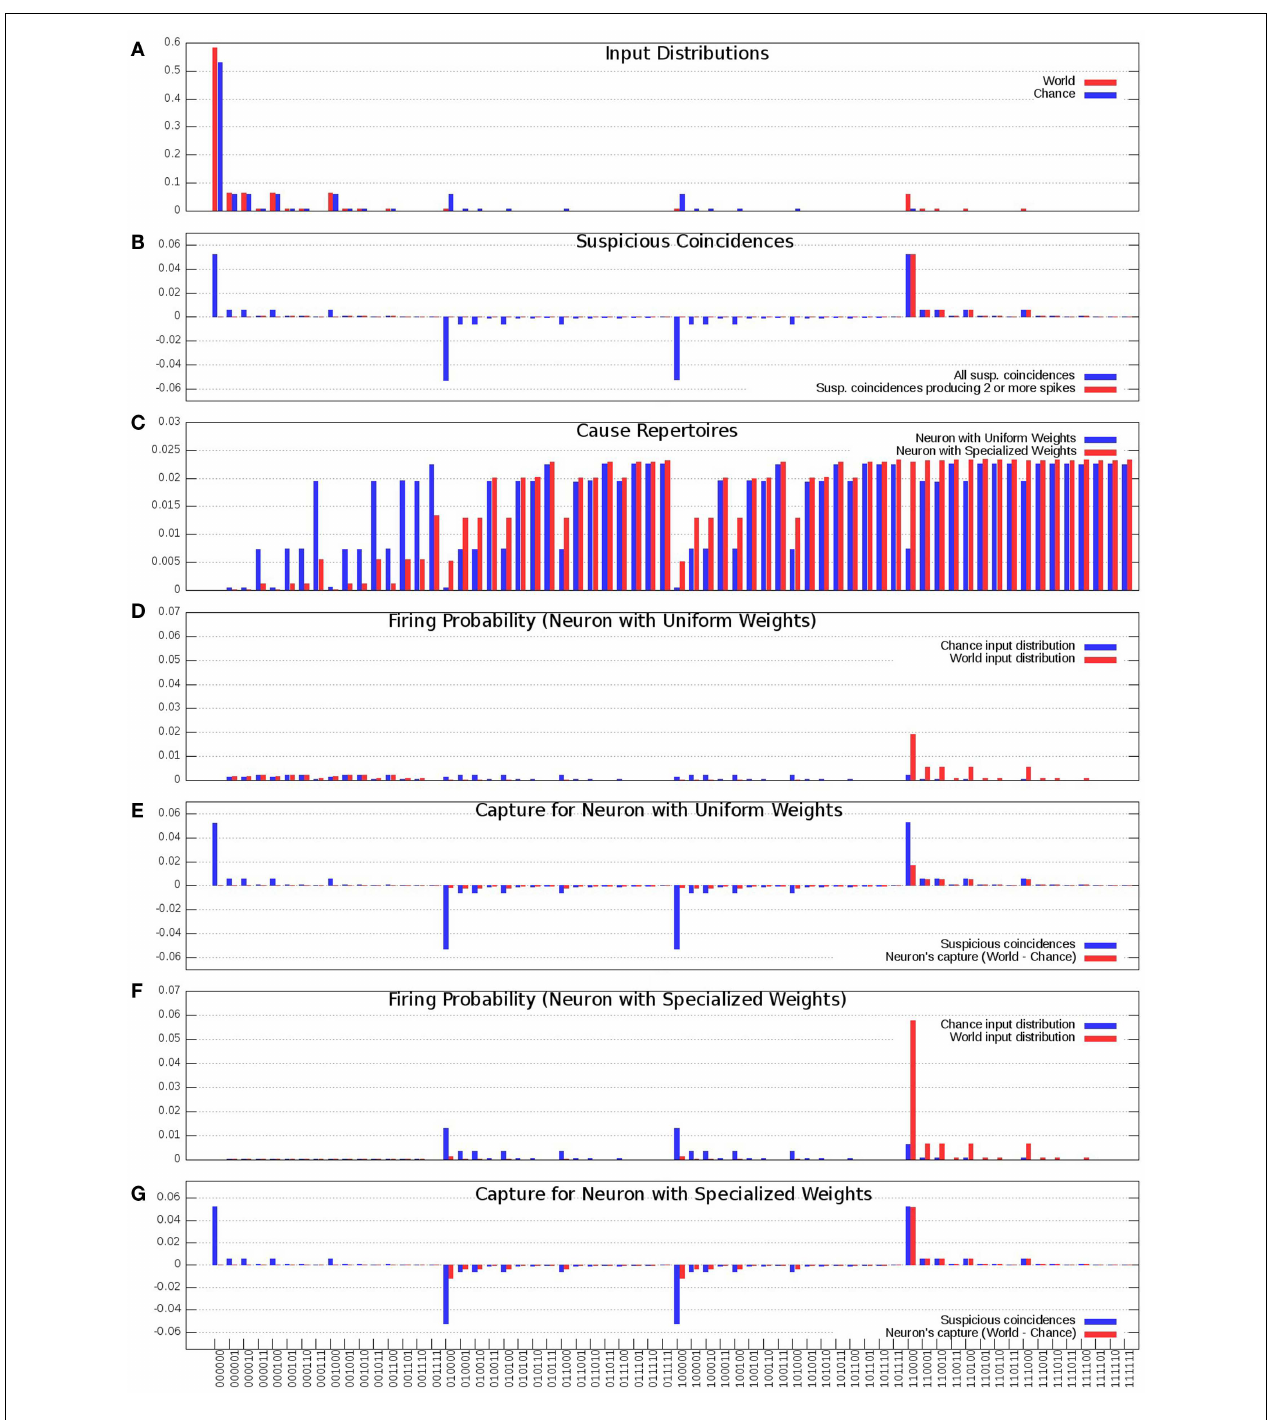
or more active inputs are shown in red. (C) Cause repertoires corresponding to the “uniform” and “specialized” neurons. (D) “Uniform” neuron’s firing probabilities in response to the Chance and World input distributions. (E) “Uniform” neuron’s capture (Red) compared against the suspicious coincidences (Blue). (F) “Specialized” neuron’s firing probabilities in response to the Chance and World input distributions. (G) “Specialized” neuron’s capture (Red) compared against the suspicious coincidences